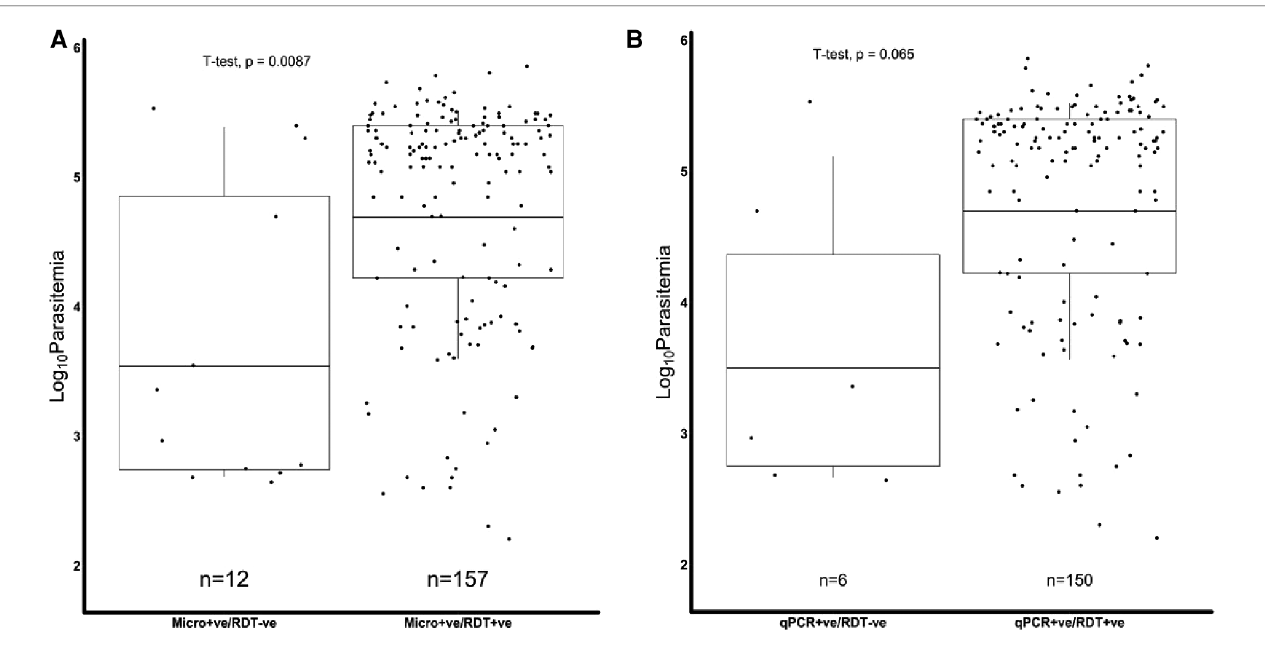
FIGURE 3 Combined Box and scatter diagrams comparing the microscopy log10 parasite densities of discordant and non-discordant samples. Horizontal lines represent the geometric means of log 10 parasitemia. ( A ) Microscopy positives where the geometric mean parasitemia (log 10 parasitemia) was 3.5 (4978.0 parasites/ μ l) for m ’ scopy+ve/RDT − ve and 4.7 (61309.7 parasites/ μ l) for m ’ scopy+ve/RDT+ve. ( B ) qPCR positives, where the geometric mean parasitemia (log 10 parasitemia) was 3.5 (4427.3 parasites/ μ l) for qPCR+ve/RDT − ve and 4.7 (62589.9 parasites/ μ l) for